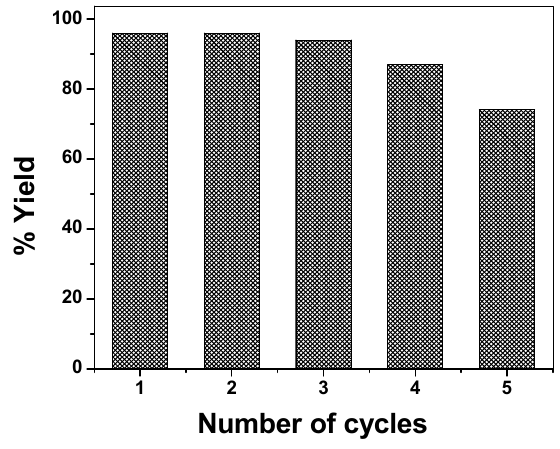
Figure 8. Re-usability of MFI27_6 catalyst.